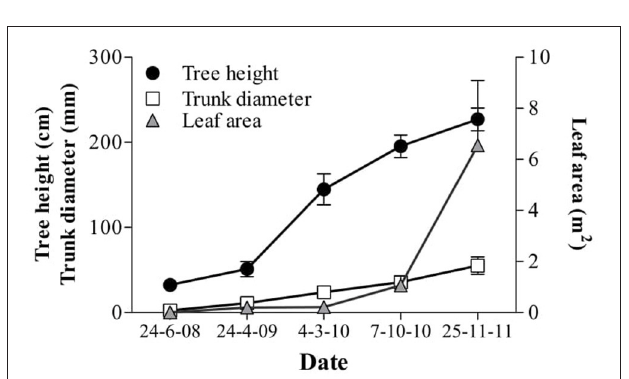
FIGURE 3 | Average components of vegetative growth of trees established at eight different intra-row spacing during 4 years after planting. Each point is a mean of 3 replicates for 8 intra-row spacings ( n = 24) ± standard deviation. No significant differences were observed among spacing